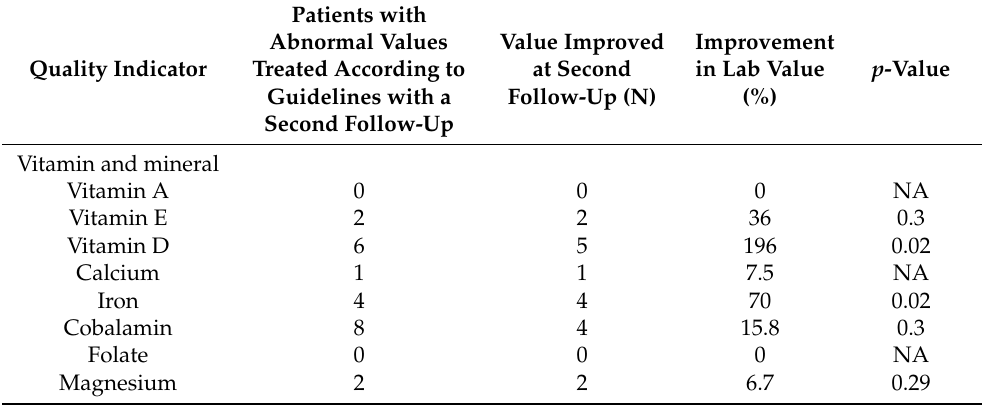
Table 5. Efficacy of